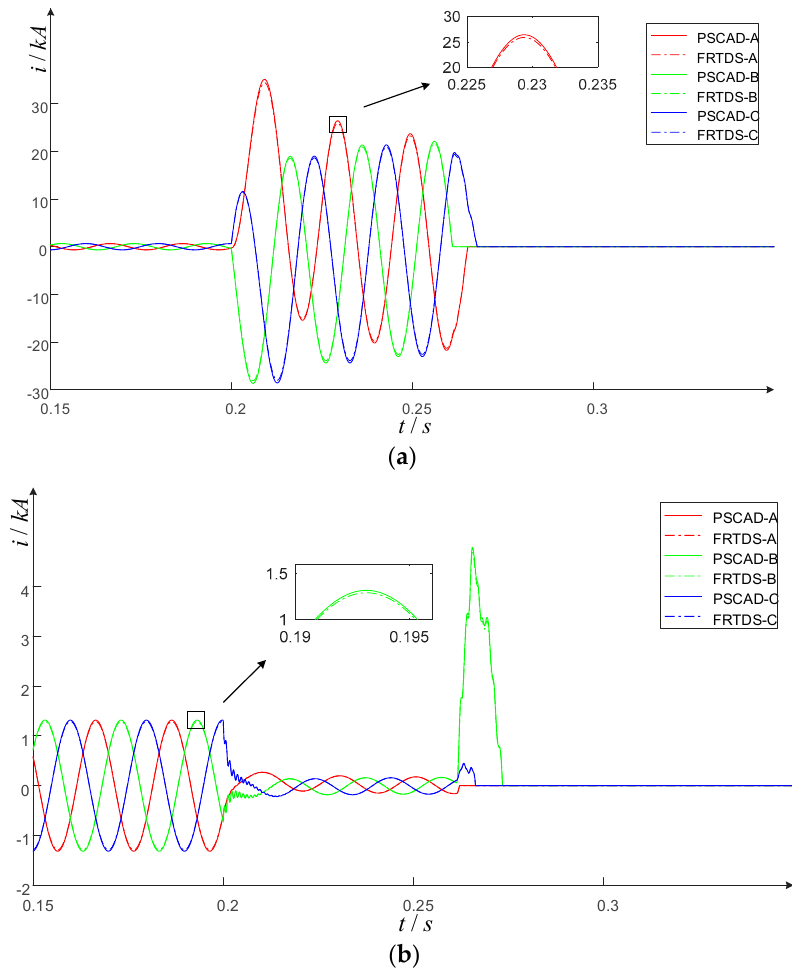
Figure 10. Three-phase current of breaker: ( a ) 213; ( b ) 113.